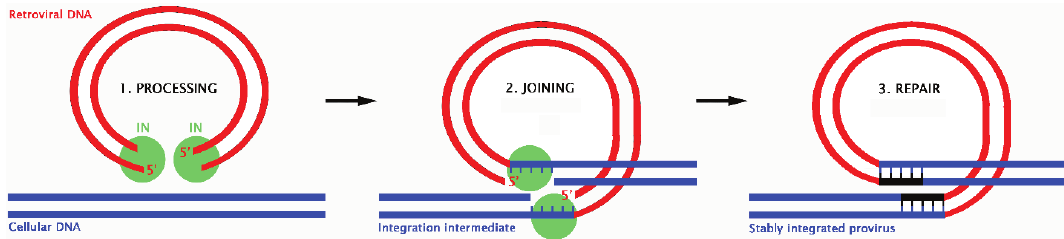
Figure 2. The basic steps in the retroviral integration process. 1. Viral integrase (IN) processes the viral DNA ends. 2. IN then catalyses the cleavage of host DNA and attachment of viral DNA forming an integration intermediate. 3. Finally, host factors repair the single strand gaps resulting in a stably integrated provirus. Image adapted from [120]. (2003) National Academy of Sciences, USA.